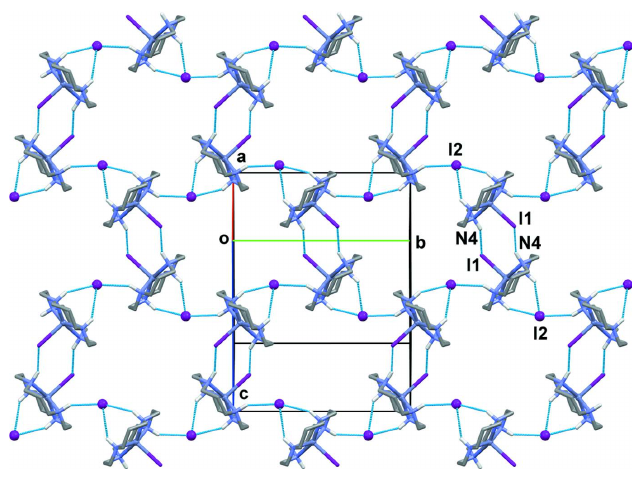
Figure 4 The structure of the hydrogen-bonded layer parallel to the ab plane in I . Hydrogen-bonding interactions are shown as dashed lines.